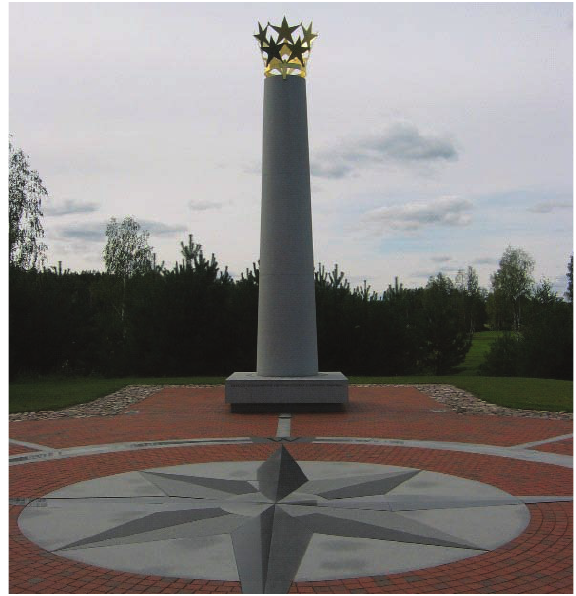
Table 1. Station Points of the Struve Geodetic Arc that have be- come part of the UNESCO world heritage